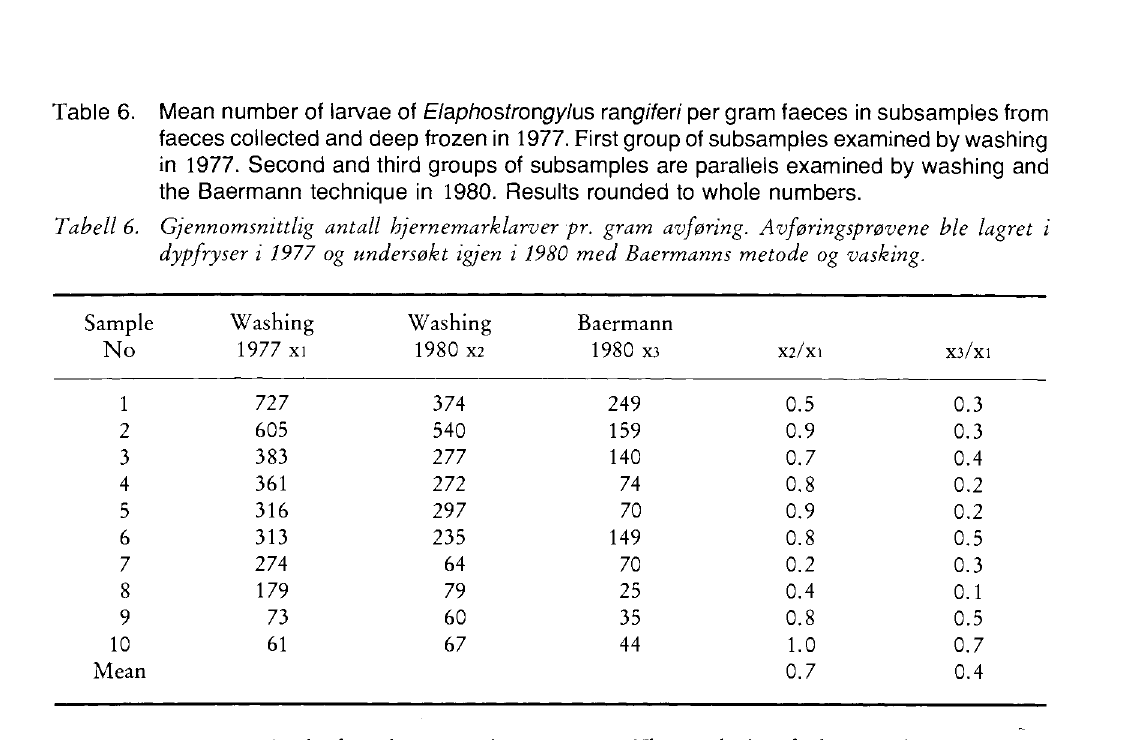
Table 6. Mean number of larvae of Elaphostrongylus rangiferi per gram faeces in subsamples